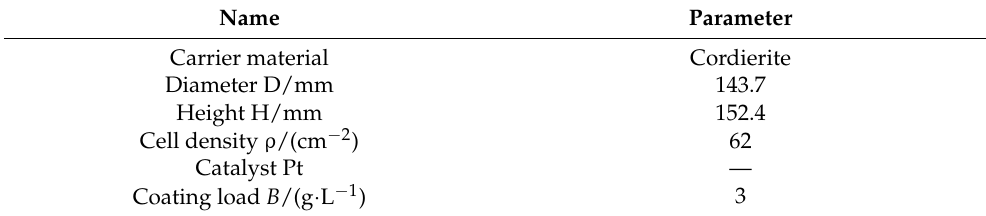
Figure 1. Schematic diagram of the engine test bench. Table 2. DOC